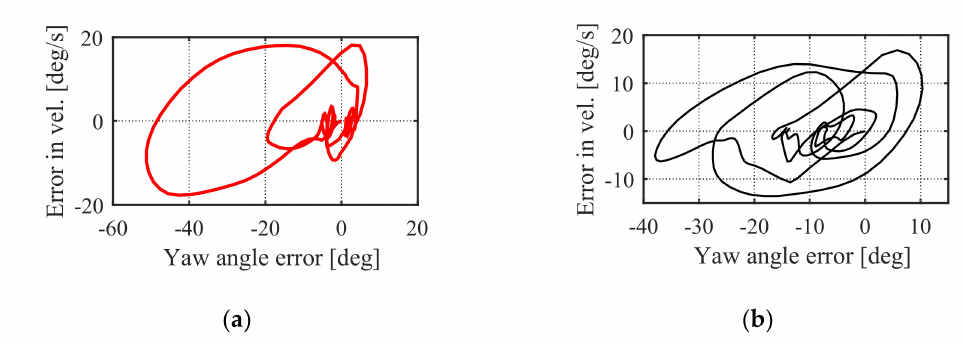
Figure 31. The experimental phase-portrait in AM mode: ( a ) Proposed controller; ( b )